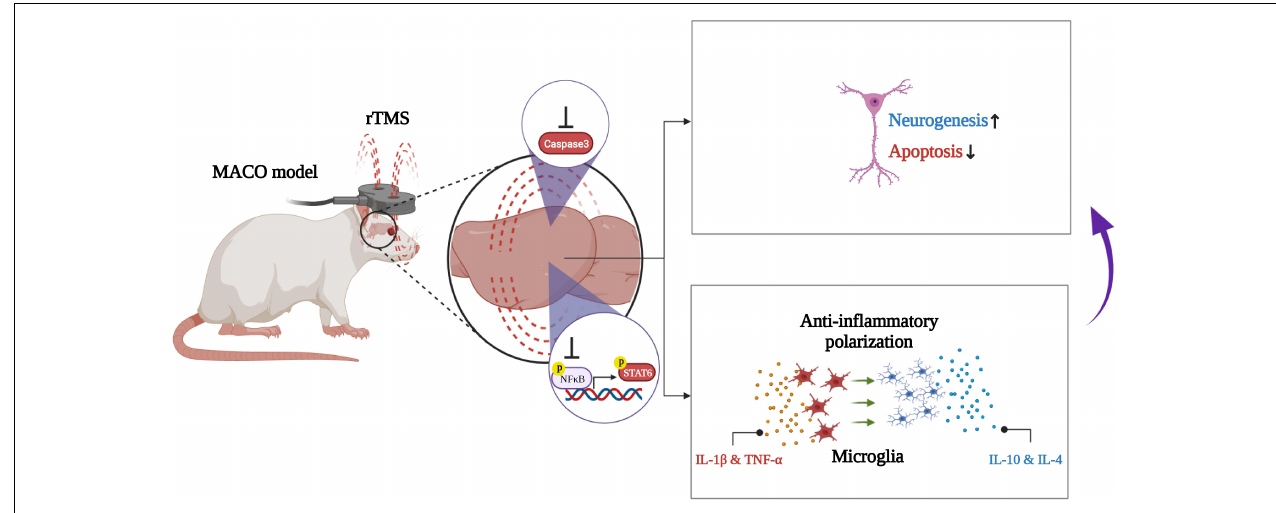
FIGURE 8 | Schematic illustration of rTMS-mediated anti-inflammatory polarization of microglia and neural recovery.